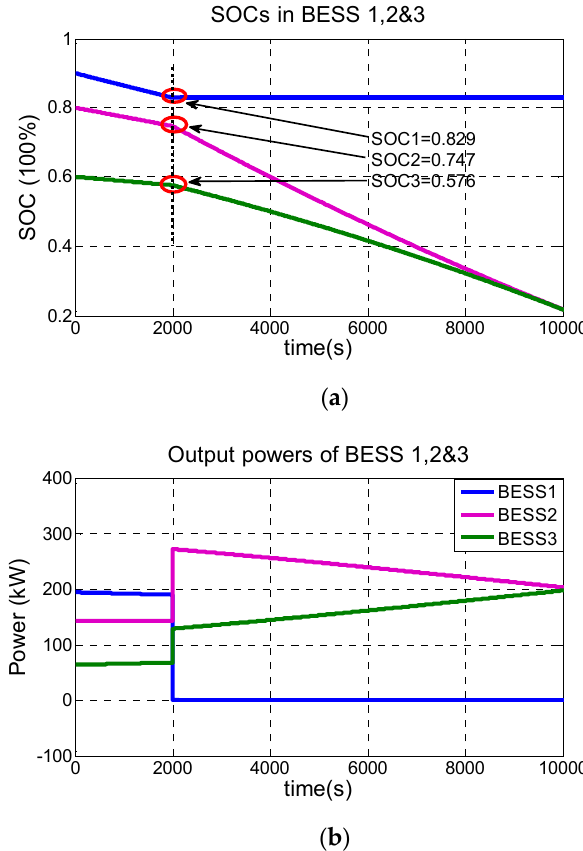
Figure 12. SOC and output waveforms in case of outage of BESS 1 . ( a ) Waveforms of SOCs and ( b ) waveforms of output powers.